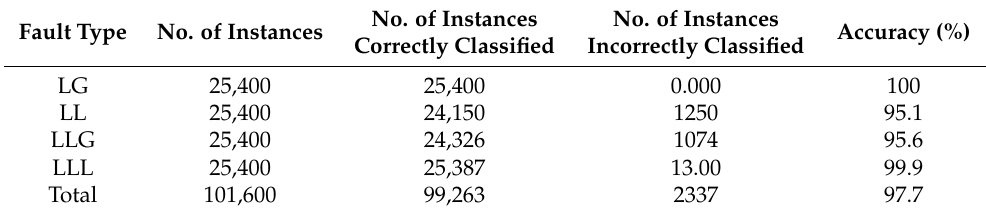
Table 18. Fault classification accuracy in different phases with PV and WE sources.